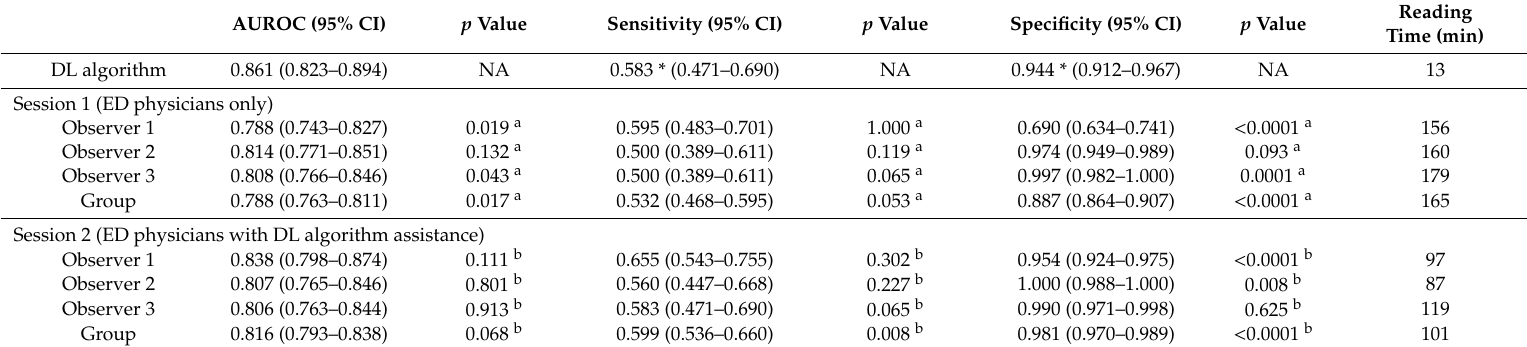
Table 2. Diagnostic Performance of DL algorithm and ED physicians (pneumonia vs. non-pneumonia).